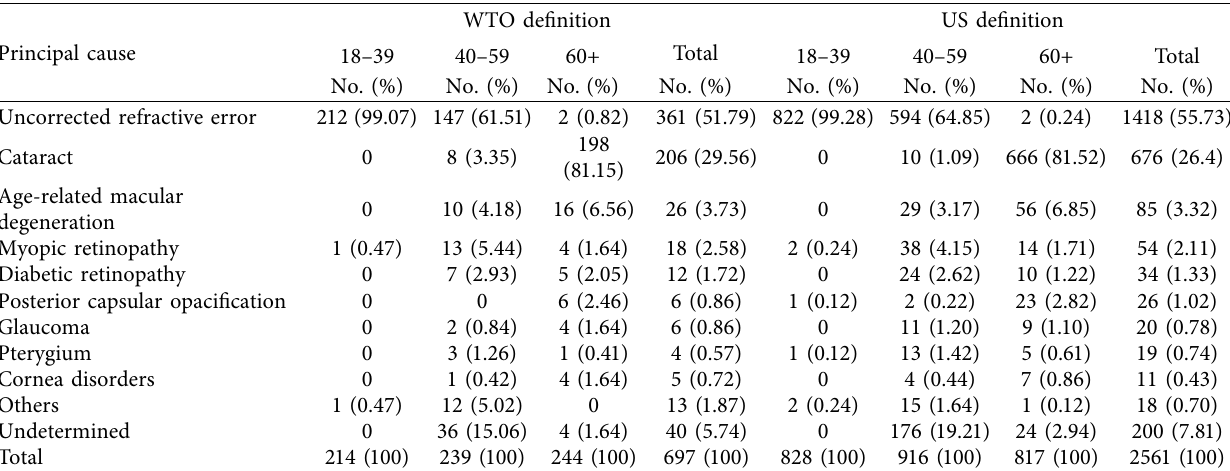
Table 3: Causes for bilateral presenting visual impairment according to WTO and US defnitions stratifed by